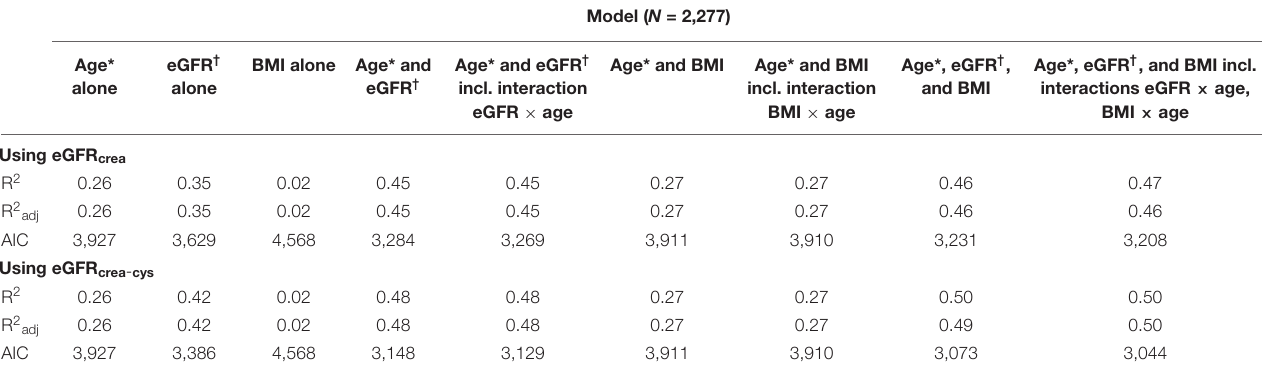
R 2 : coefficient of determination, R 2 adj : adjusted R 2 , AIC: Akaike’s information criterion. *Modeled with a linear and cubic component. † Modeled with a linear, quadratic, and cubic